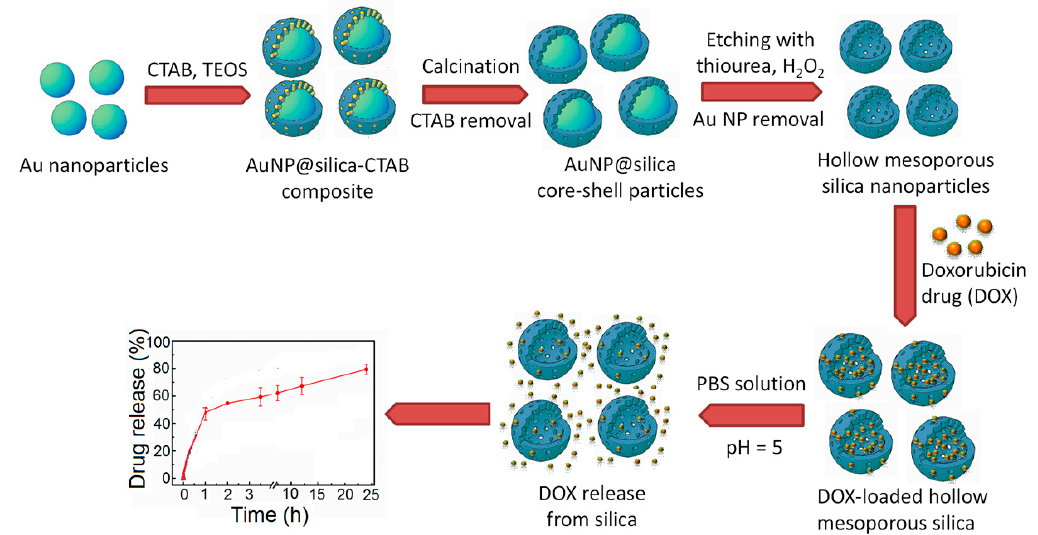
Figure 13. Loading of doxorubicin hydrochloride (DOX) drug onto hollow mesoporous silica and its release efficiency.